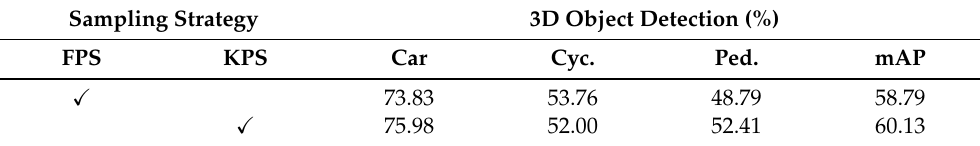
Table 8. Comparison of sampling strategies of Pseudo Point Cloud Generation network to PTA-Det. Sampling